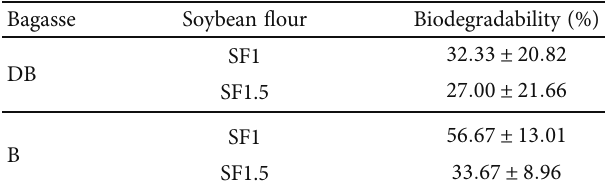
Figure 11: Biofoam sample with 1x magnitude: before the biodegradability test (a) and after the biodegradability test Table 2: Biodegradability test of biofoam cup after 14 days.